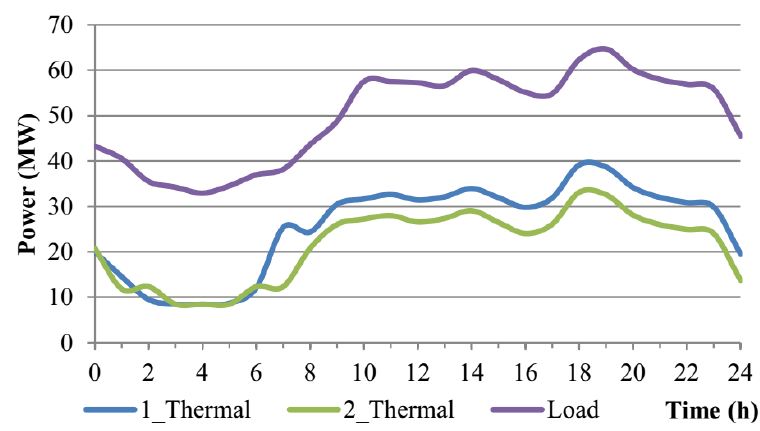
Figure 4. Thermal diagram comparison with load diagram.